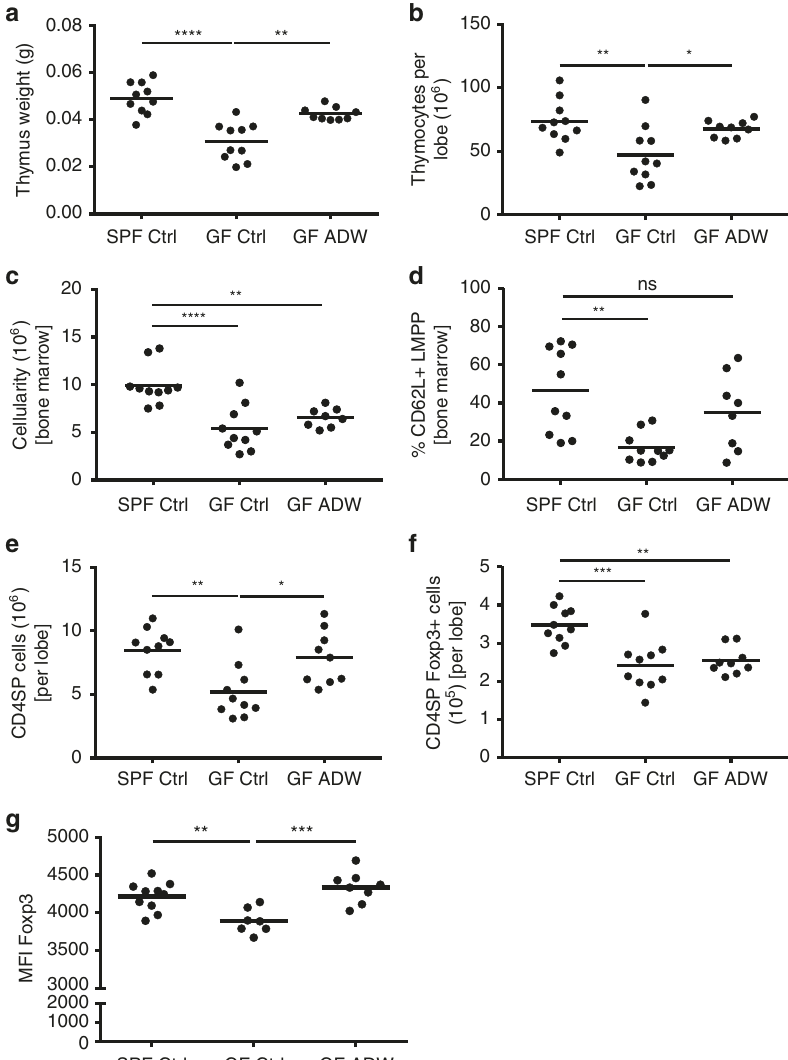
Fig. 6 Reduced Foxp3 MFI in thymic Treg cells from GF pups recovered with acetate supplementation. Three-week-old C57BL/6 pups from control SPF and GF mothers and GF mothers treated with acetate in drinking water (ADW). Cumulative data showing phenotypic analysis by fl ow cytometry in the thymus from pooled female and male pups ( n = 7 – 10/group). a Thymus weight. b Thymocyte cellularity per thymic lobe. c Bone marrow cellularity. d